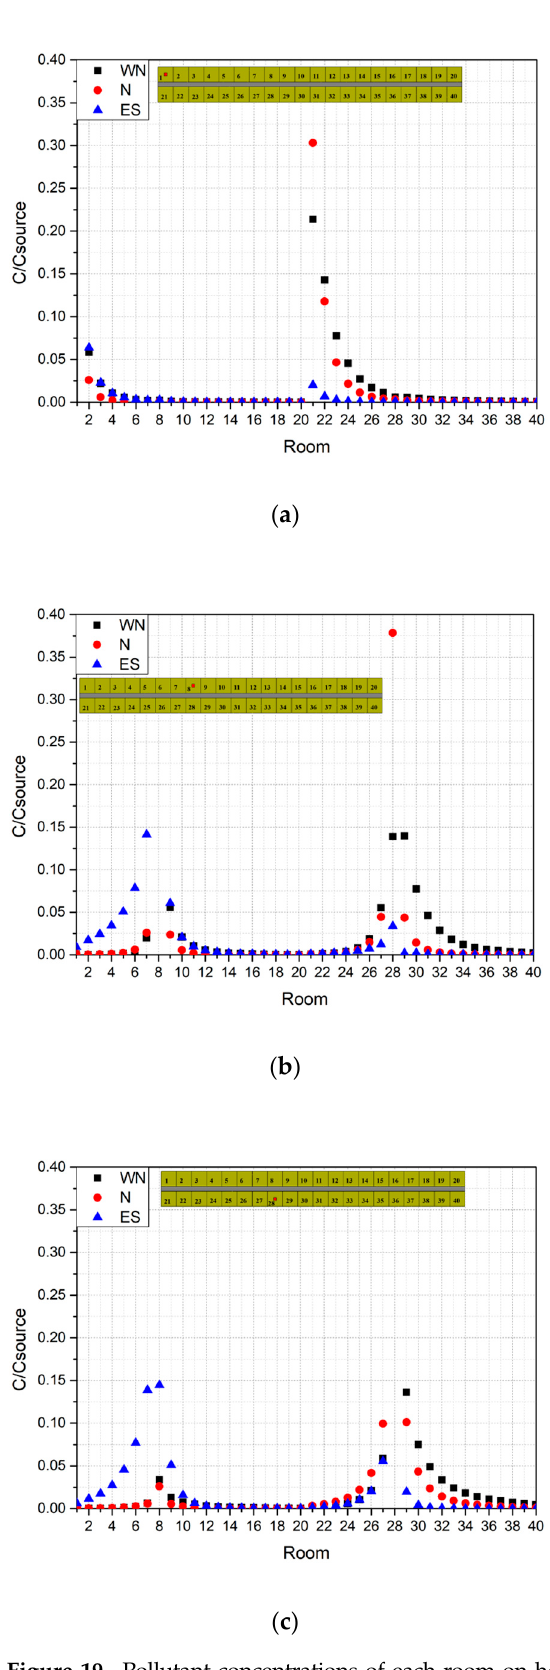
Figure 19. Pollutant concentrations of each room on horizontal plane Z = 0.76 m with three source locations under three wind directions. ( a ) Source 1: Room 1. ( b ) Source 2: Room 8. ( c ) Source 3: Room 28.